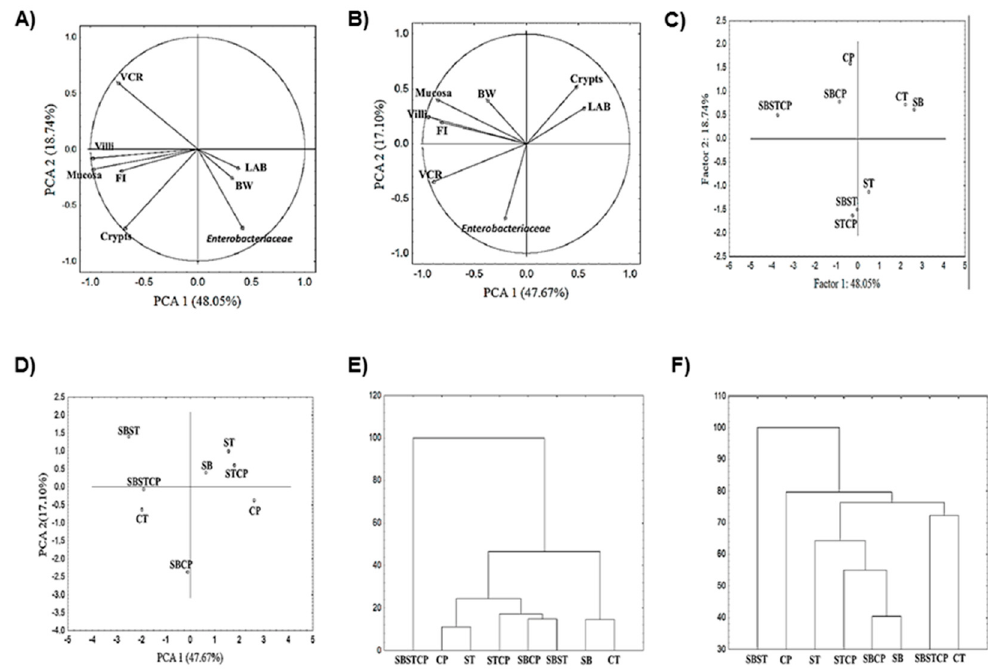
Figure 4. Principal component analysis (PCA) plots of broilers treated with a Synbiotic mix. ( A ) Location of different variables at 18 days; ( B ) location of different variables at 39 days; ( C ) location of different treatments at 18 days; ( D ) location of different treatments at 39 days; ( E ) dendrogram of hierarchical cluster analysis at 18 days; ( F ) dendrogram of hierarchical cluster analysis at 39 days. BW: body weight, VCR: villi-crypt ratio, FI: feed intake, LAB: Lactic Acid Bacteria. CT: non-challenged Control group; SB: Synbiotic mix; SBST: Synbiotic mix + S. Typhimurium; ST: S. Typhimurium; SBCP: Synbiotic mix + C. Perfringens ; CP: C. Perfringens ; SBSTCP: Synbiotic mix + S. Typhimurium + C.